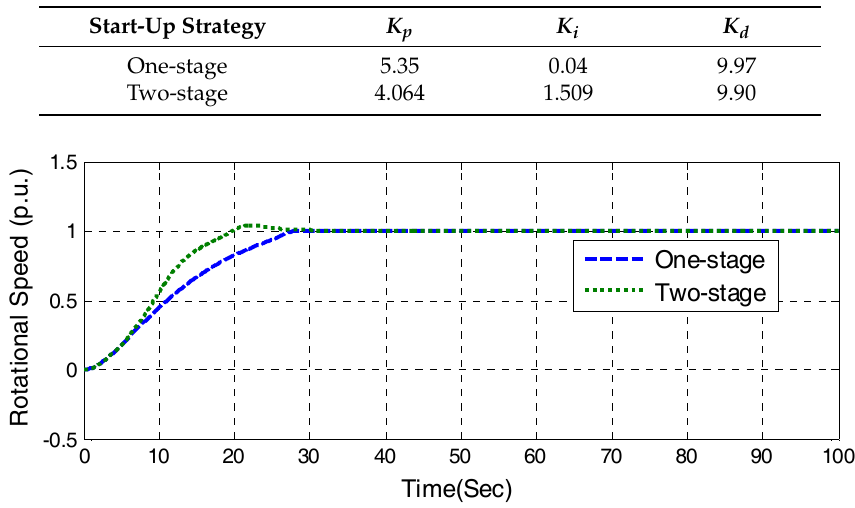
Figure 15. Rotational speed of traditional start-up strategies with Scheme A.